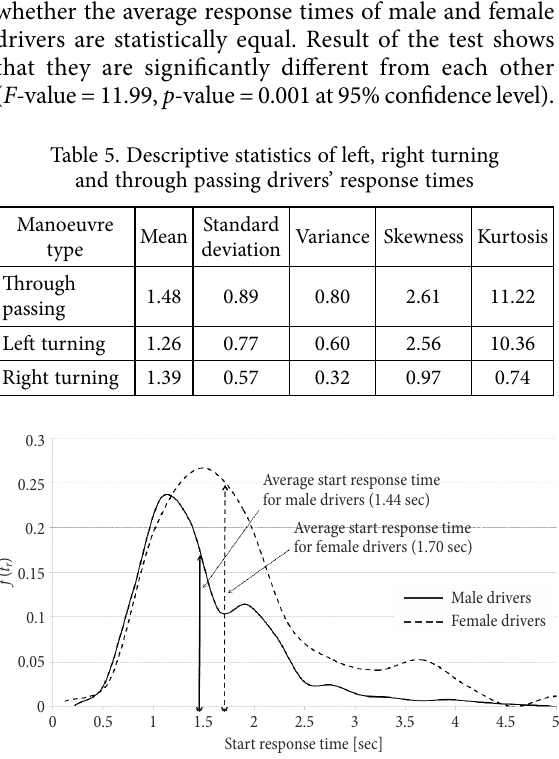
Average t for left turning vehicles (1.26 sec) r Average t for right turning vehicles (1.39 sec) r Average t for through passing vehicles (1.48 sec) r